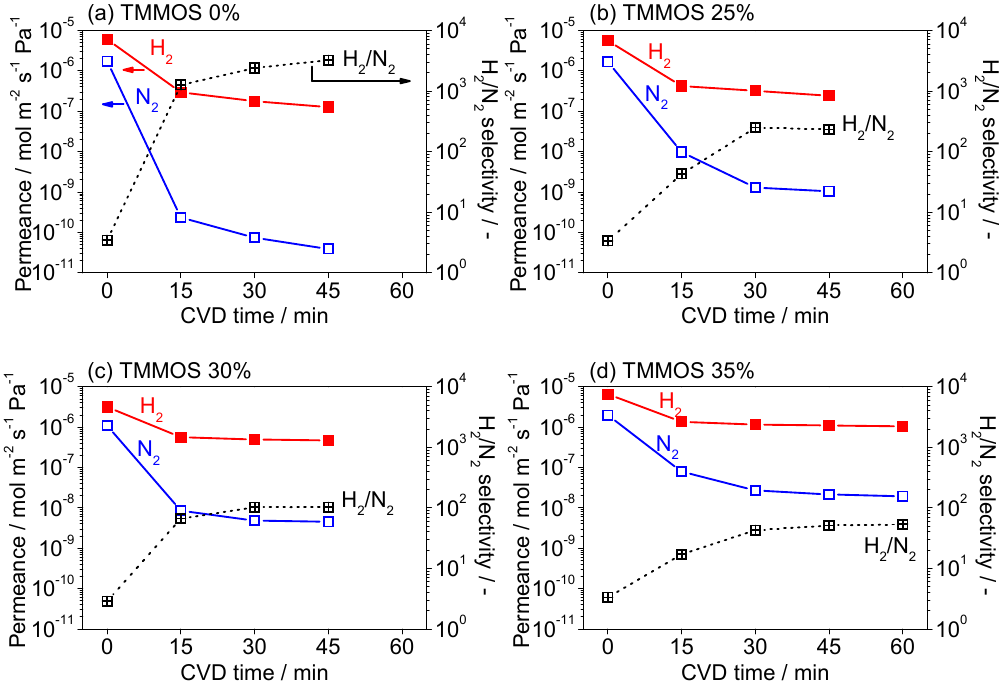
Figure 4. Chemical vapor deposition (CVD) results H 2 and N 2 permeance and H 2 / N 2 selectivity as a function of CVD time ( a ) TMMOS 0%, ( b ) TMMOS 25%, ( c ) TMMOS 30%, and ( d ) TMMOS 35%.